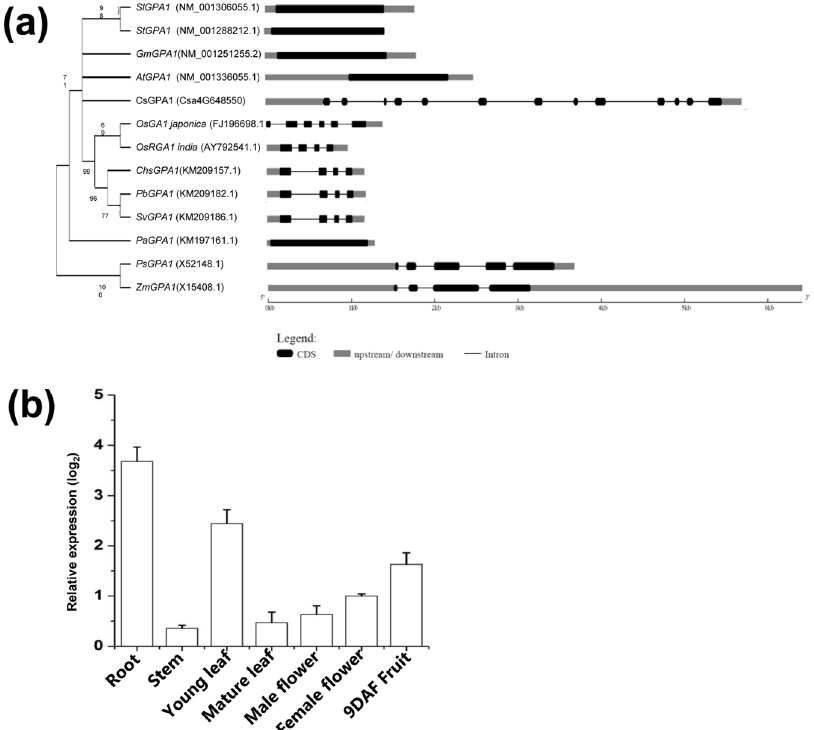
Figure 1. Optimal phylogenetic tree with the sum of branch lengths = 0.2. ( a ) The percentage of replicate trees in which the associated taxa clustered together in the bootstrap test (1,000 replicates) is indicated next to the branches. The evolutionary distances were computed using the Poisson correction method and are indicated as the number of mRNA substitutions per site. Thirteen mRNA sequences were included in the analysis. All positions with gaps and missing data were eliminated. A total of 199 positions were included in the final dataset. Evolutionary analyses were conducted with MEGA7 (Kumar et al . 15 ). A phylogenetic analysis of the GPA1 gene was completed using the neighbor-joining method of the MEGA7 software for the following species: Cucumis sativus (cucumber), Zea mays , Oryza sativa subsp . indica , Oryza sativa subsp . japonica , Pisum sativum